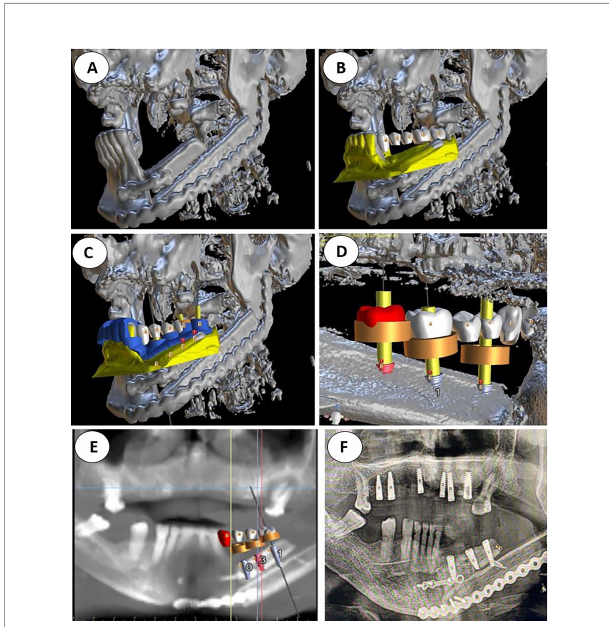
FIGURE 1 | (A) Double barrel fi bula fl ap CBCT 16 months after irradiation with 70 Gy. A basal reconstructive plate and a crestal miniplate. (B) Scanned lower jaw plaster model merged with the CBCT and virtual tooth design. (C) Prosthetically driven implant planning and in blue the teeth supported rigid splint designed with windows for insertion veri fi cation. (D) Lingual view seen from the fl oor of the mouth of the crestal fi bula segment and the prosthetically driven implant placement. (E) VSP, preoperative implant planned position superimposed in the CBCT (F) Postoperative